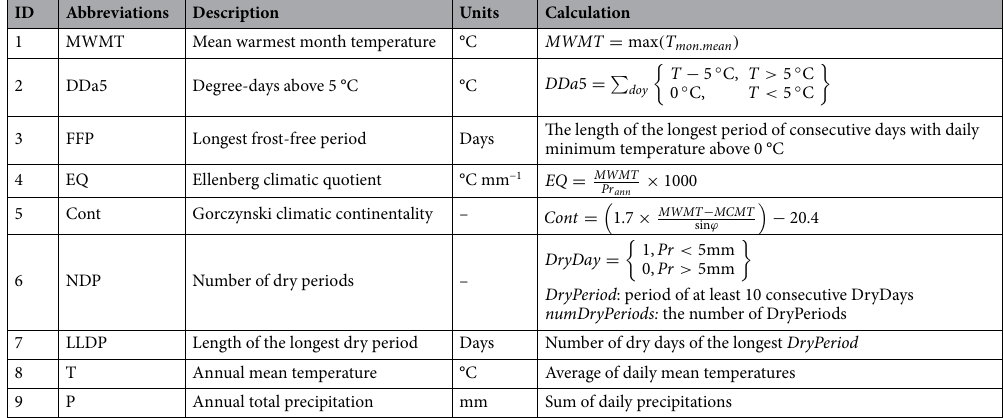
Table 1. Climate variables used as predictors of future climate stability, all calculated on annual basis ( T temperature, Pr precipitation, MCMT mean coldest month